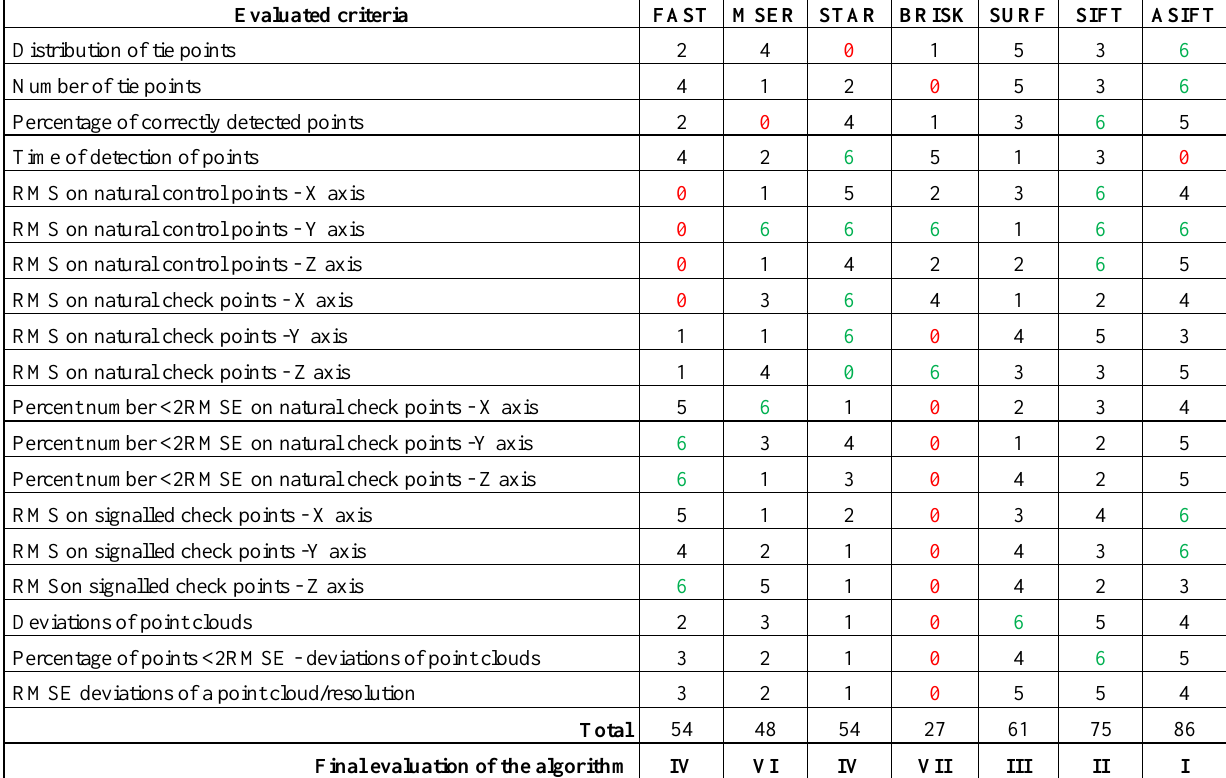
Table 7 Test results for analysed